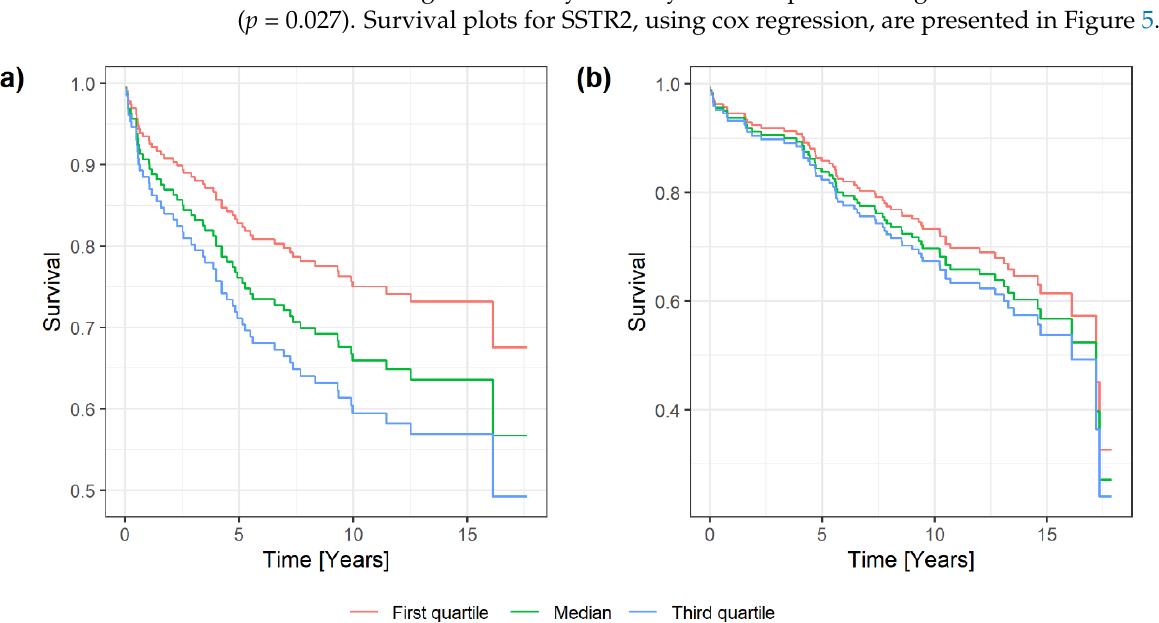
Table 5. Association between SSTRs expression and overall survival (OS) or recurrence (TTR) from univariate Cox regression analyses. Significant results marked in bold.